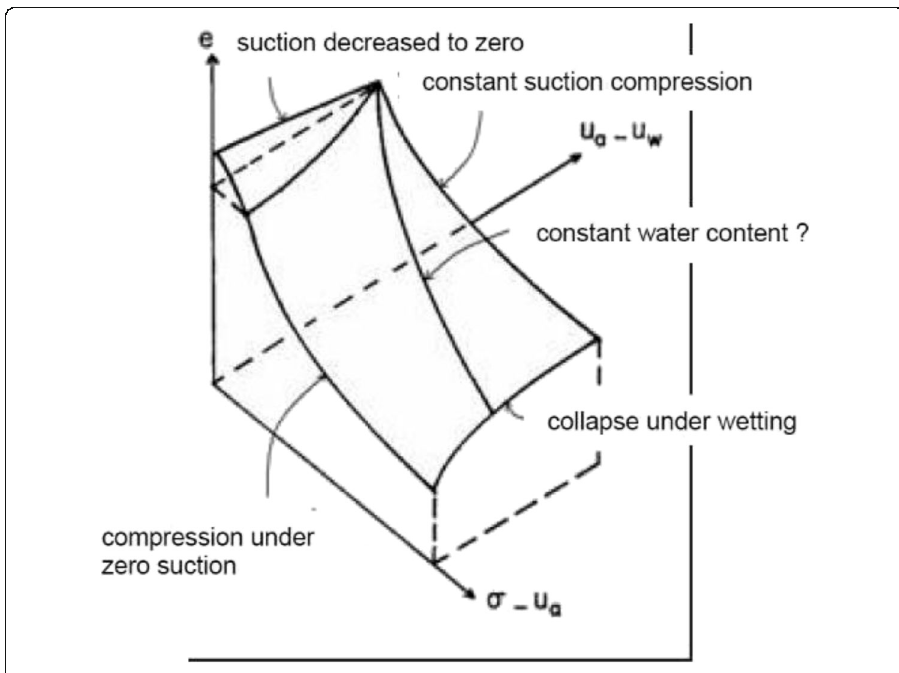
Fig. 5 Stress state surface concept, e vs. ( σ – u w ) vs. ( u a – u w ) (adopted from Delage et al.